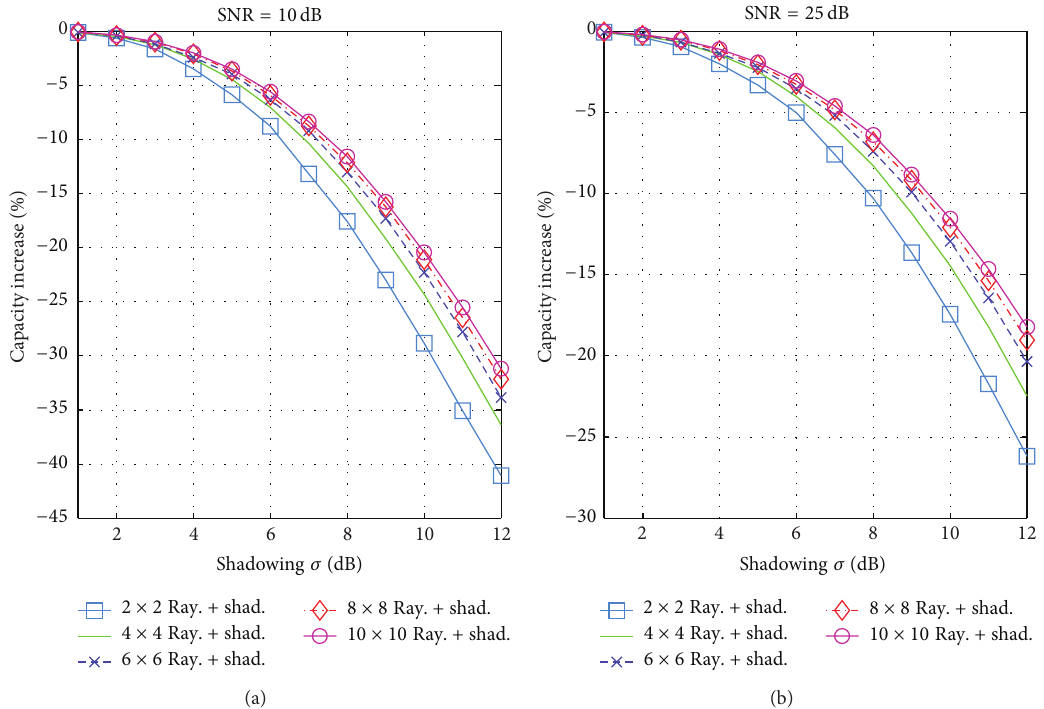
Figure 4: Capacity increase relative to Rayleigh-only fading versus sigma shadowing, (a) with SNR = 10 dB, (b) with SNR = 25 dB.